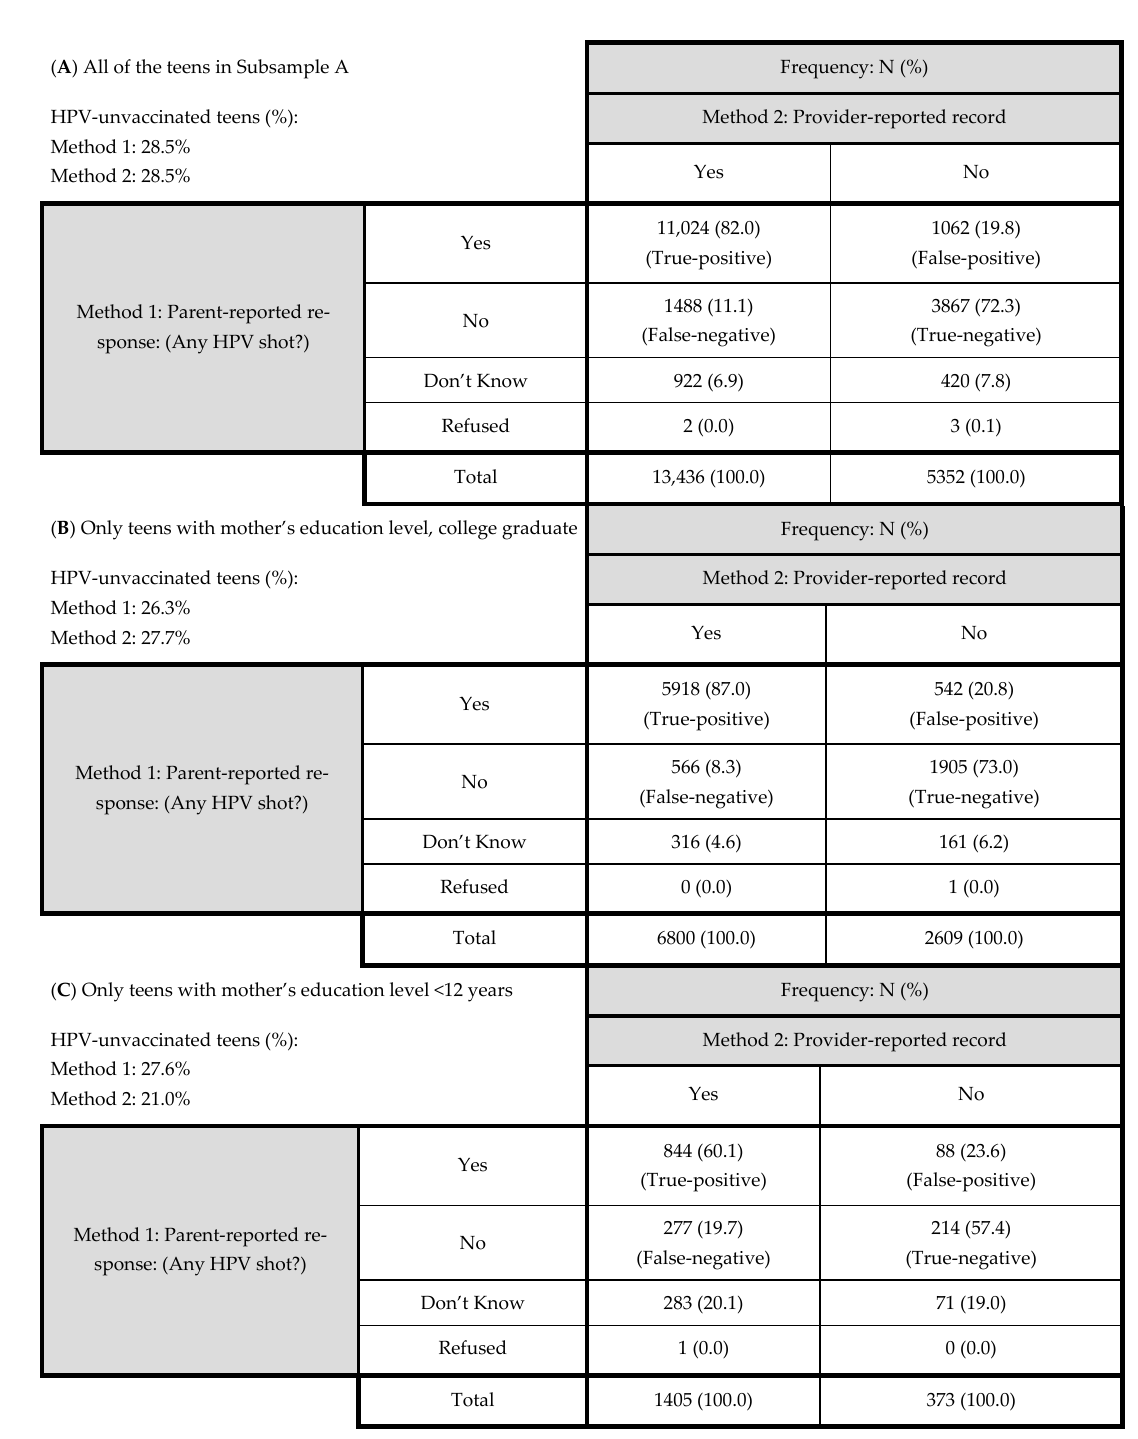
Figure 2. Comparison of the parent-reported responses (Method 1) against the provider-reported vaccination records (Method 2: the reference) for ( A ) all of the teens in Subsample A (N = 18,788), ( B ) only teens with mother’s education level (college graduate) (N = 9409), and ( C ) only teens with mother’s education level (<12 years) (N = 1778) of Subsample A. HPV: human papillomavirus. False negative cases are significantly higher in Figure 2C (19.7%) than in Figure 2B (8.3%). Additionally, a greater difference in the proportion of unvaccinated teens between Methods 1 and 2 can be observed in Figure 2C (6.6%) than in Figure 2B